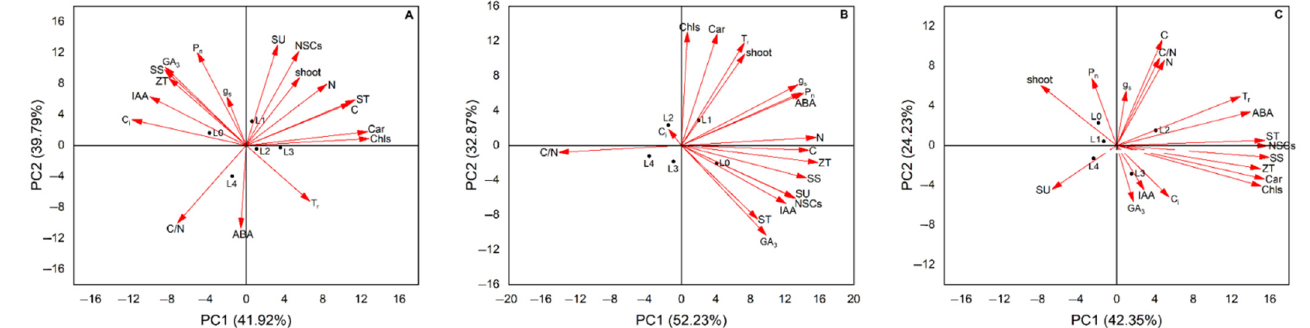
Figure 7. PCA diagram of the number of germinated bamboo shoots and leaf physiochemical attributes for Ma bamboo under the different light treatments by shooting period was ( A ) shooting initial-phase, ( B ) shooting metaphase, and ( C ) shooting anaphase. Note: shoot—the number of germinated